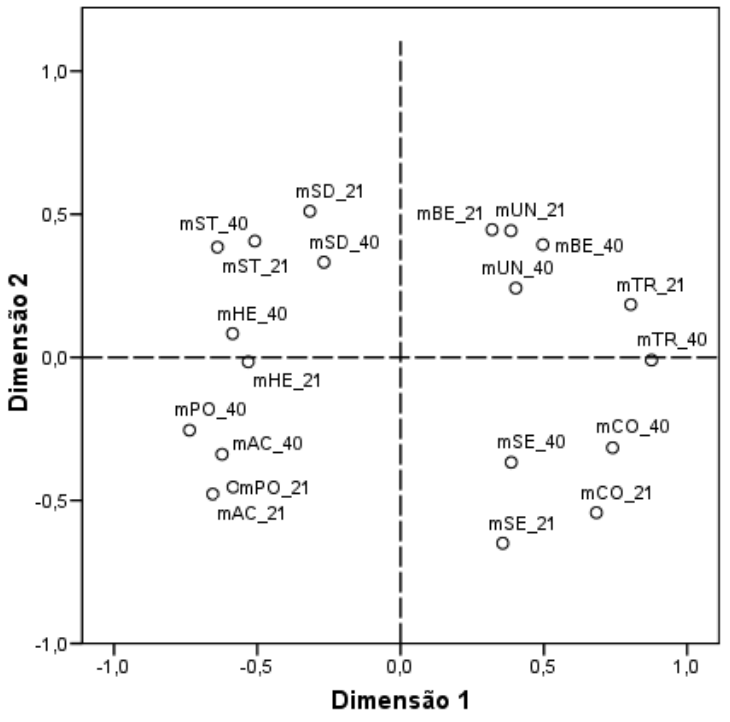
Figura 8. WCMDS (PVQ-40 e